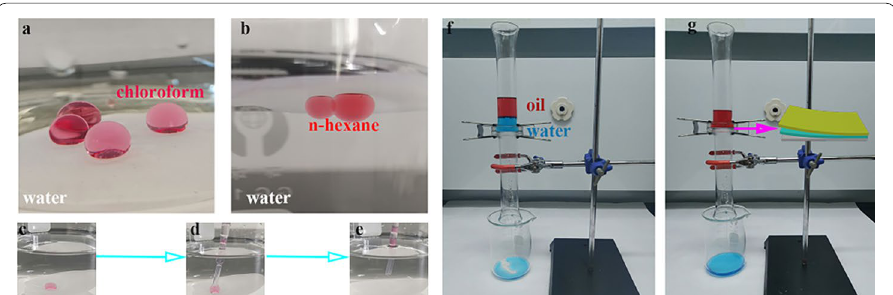
Fig. 8 Photographs of oil droplets underwater. Chloroform, n-hexane (red); water (blue). a Chloroform (bottom side, heavier than water), b n-hexane (top side, lighter than water) in water on the surface of silica/PM. c – e The images of chloroform oil droplet nonadhesive on the surface of the silica/PM. f , g The photographs of the measurement of the oil/water separation performance of silica/PM, f before separation and g after separation,